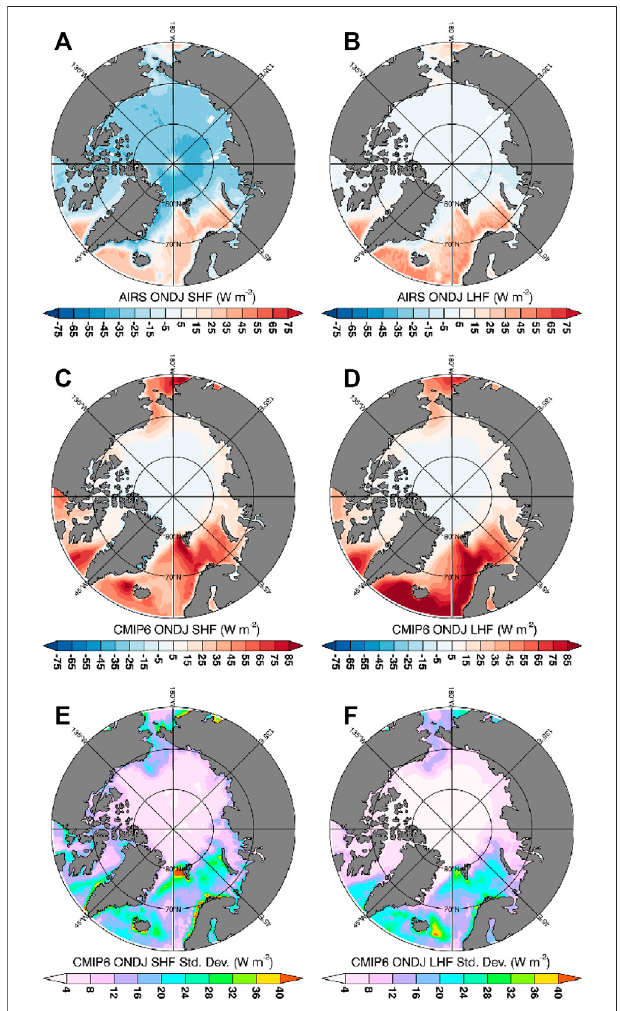
FIGURE 2 | Average winter (ONDJ) SHF and LHF from 2002 to 2020 for AIRS-derived (A,B) and CMIP6 (C,D) and across-model spread represented as the standard deviation (E,F)